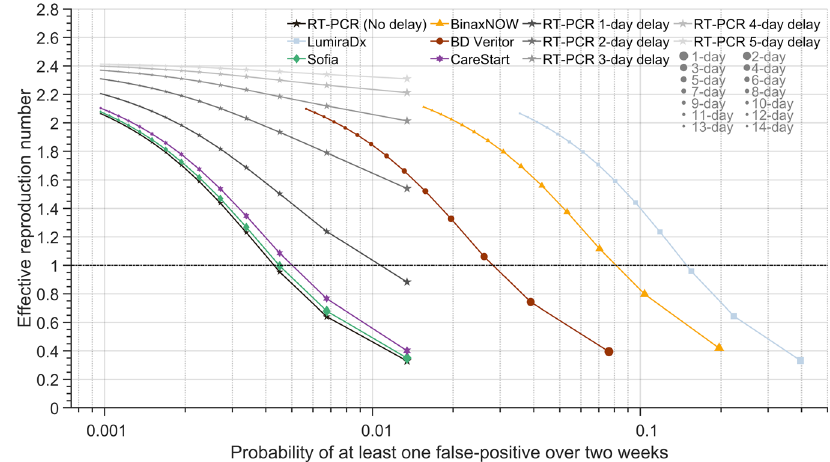
Fig. 4 The effective reproduction number, and risk of one or more false positives, for varying frequencies of serial testing with RT-PCR and rapid antigen tests. Specifying 35.1% of infections being asymptomatic, a 24-h delay before receiving RT-PCR results, no delay before receiving rapid antigen test results, an incubation period of 4.4 days, self-isolation upon symptom onset, and a RT-PCR diagnostic sensitivity curve informed by data from Hellewell et al. 11 , the expected transmission with serial testing using RT-PCR test with no delay to fi ve-day delay (black stars gradient) in obtaining test results and the rapid antigen test LumiraDx (light-blue squares); So fi a (green diamonds); BinaxNOW (yellow triangles); BD Veritor (dark-red circles); and CareStart (purple hexagrams) for testing everyday to every 14 days and isolating positives (small dots: longer time between tests; larger dots: shorter time between tests) and the corresponding probability of at least one false positive over a two-week period ( x